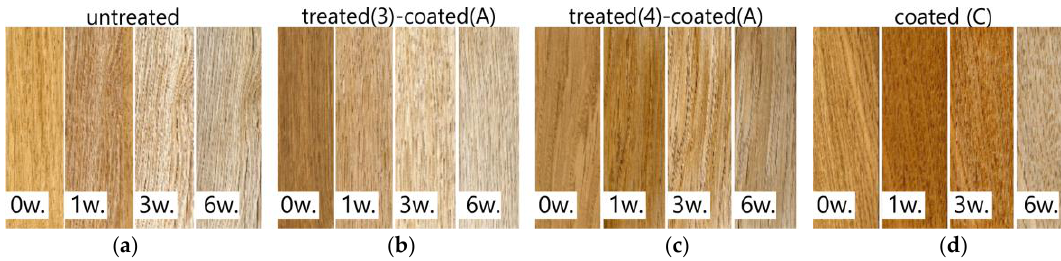
Figure 7. Photo demonstrating colour changes of selected tested samples after 0, 1, 3, and 6 weeks (w.) of accelerated weathering. ( a ) native untreated oak wood; ( b ) treated (3)–coated (A); ( c ) treated (4)–coated (A); ( d ) coated (C). A: oak wood with the nano-based hydrophobic coating; 3, 4: the types of oak wood surface treatments; C: oil-based coating—see Tables 1 and 2. The similar trends of discolouration of hydrophobic coatings (B) and (A) were observed.